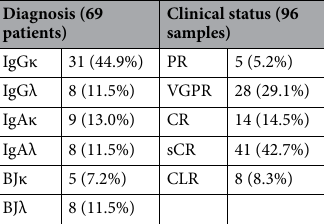
Table 1. Characteristics of the patients’ diagnosis and clinical status when each sample was analyzed. CR complete response, sCR stringent CR, VGPR very good partial response, PR partial response, CLR clinical